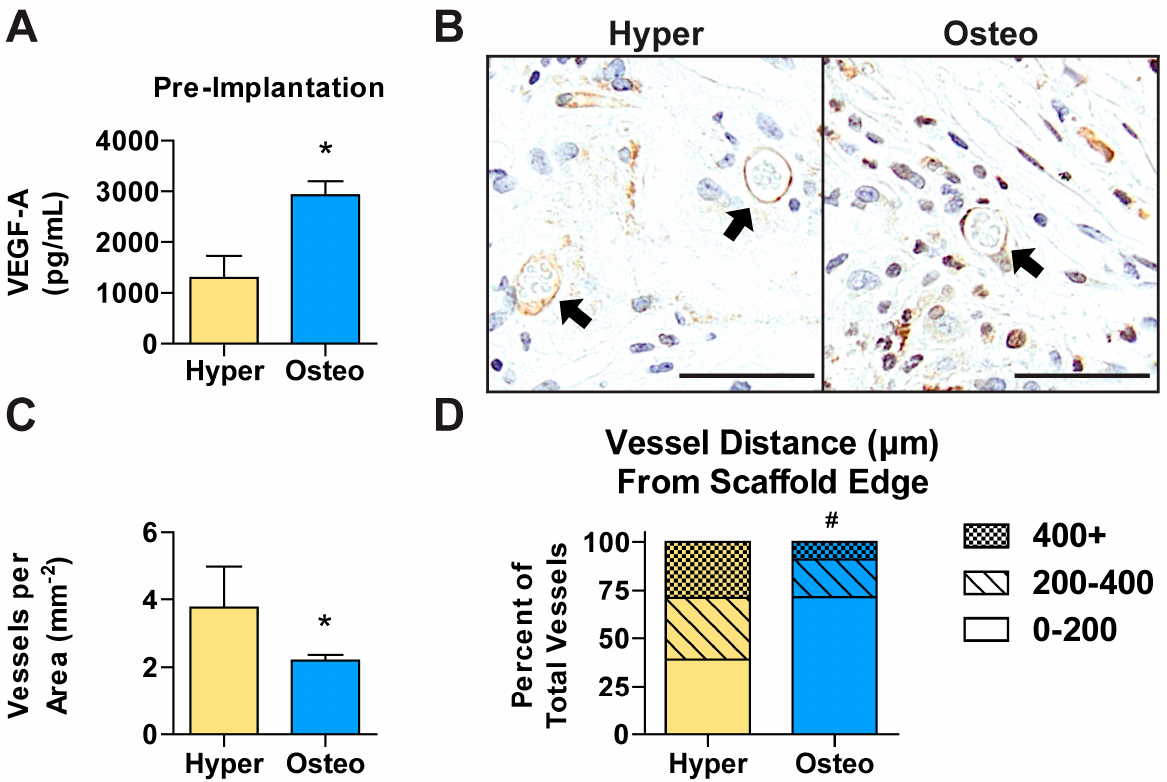
Figure 6. Vascularization of the constructs. ( A ) The concentration of VEGF-A was determined in the culture media of both the hyper and osteo constructs. ( B ) CD31 immunohistochemistry at 6 weeks demonstrated the presence of vessels (black arrows) within the constructs. ( C ) Semi-quantitative analysis of CD31+ vessels per construct area. ( D ) Histogram showing the distance of the vessels from the nearest scaffold edge, grouped into three distance ranges: 0–200 µ m, 200–400 µ m and above 400 µ m. Scale bars: 50 µ m. All data ( n = 4) are shown as the average ± SD. * Significant differences between the groups ( p < 0.05), # Significant differences in the distribution of the vessels’ distances from the nearest scaffold edge ( p < 0.05).